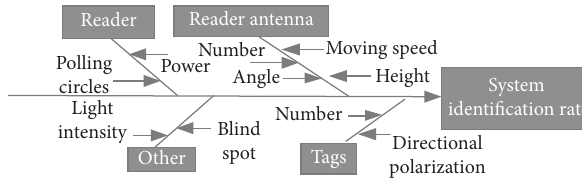
Figure 2: Influencing factors and the system identification